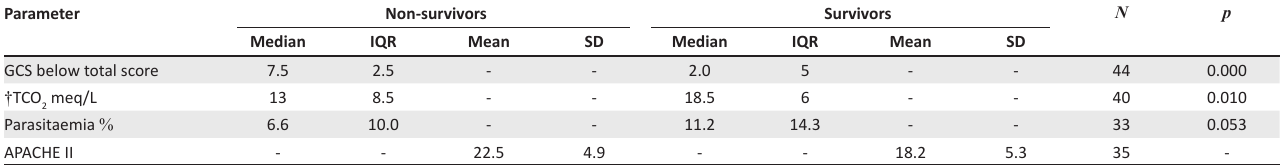
TABLE 5: Differences between survivors and non-survivors using the Mann–Whitney U test or T -test for independent samples. Parameter